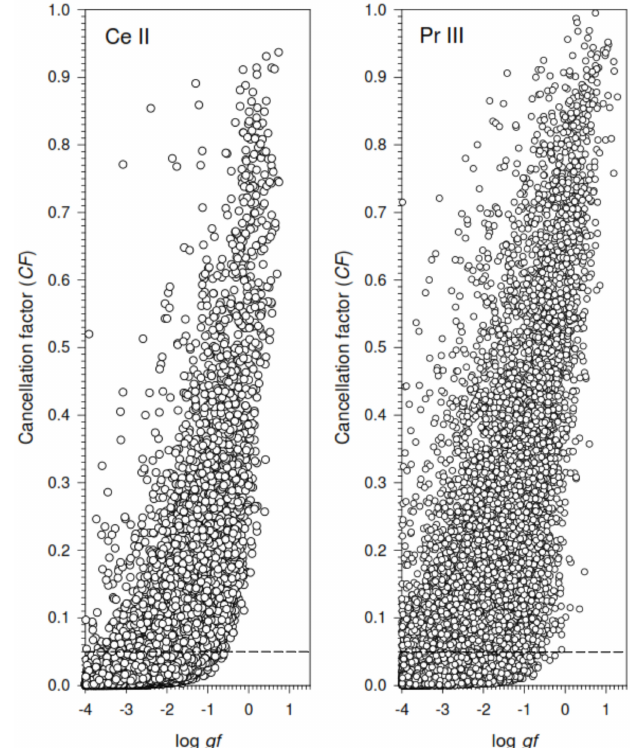
Figure 5. Cancellation factors ( CF ) plotted as a function of log gf -values as reported in the DREAM database for Ce II and Pr III spectral lines. The dashed lines correspond to CF =